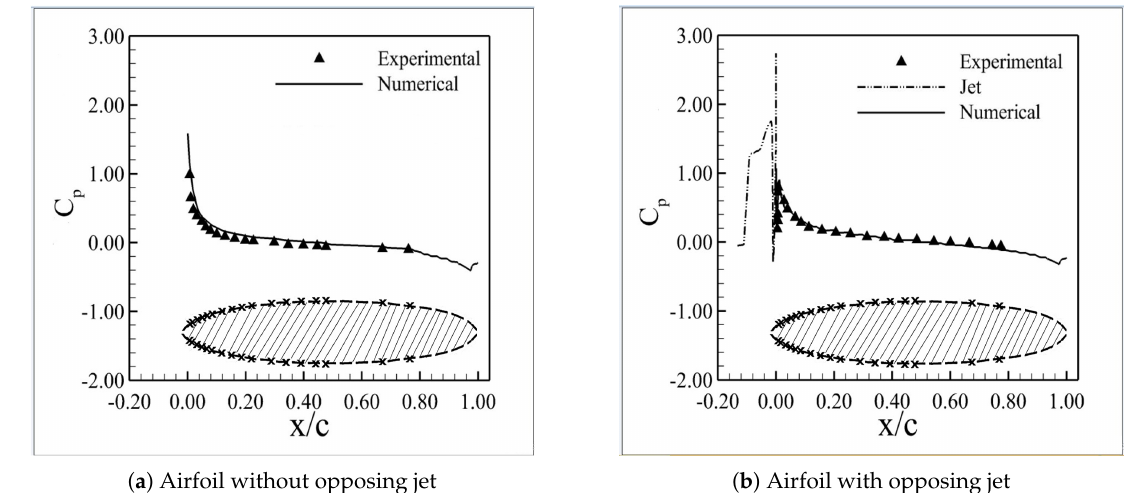
Figure 4. Validation of C p for with and without jet case over elliptical body.